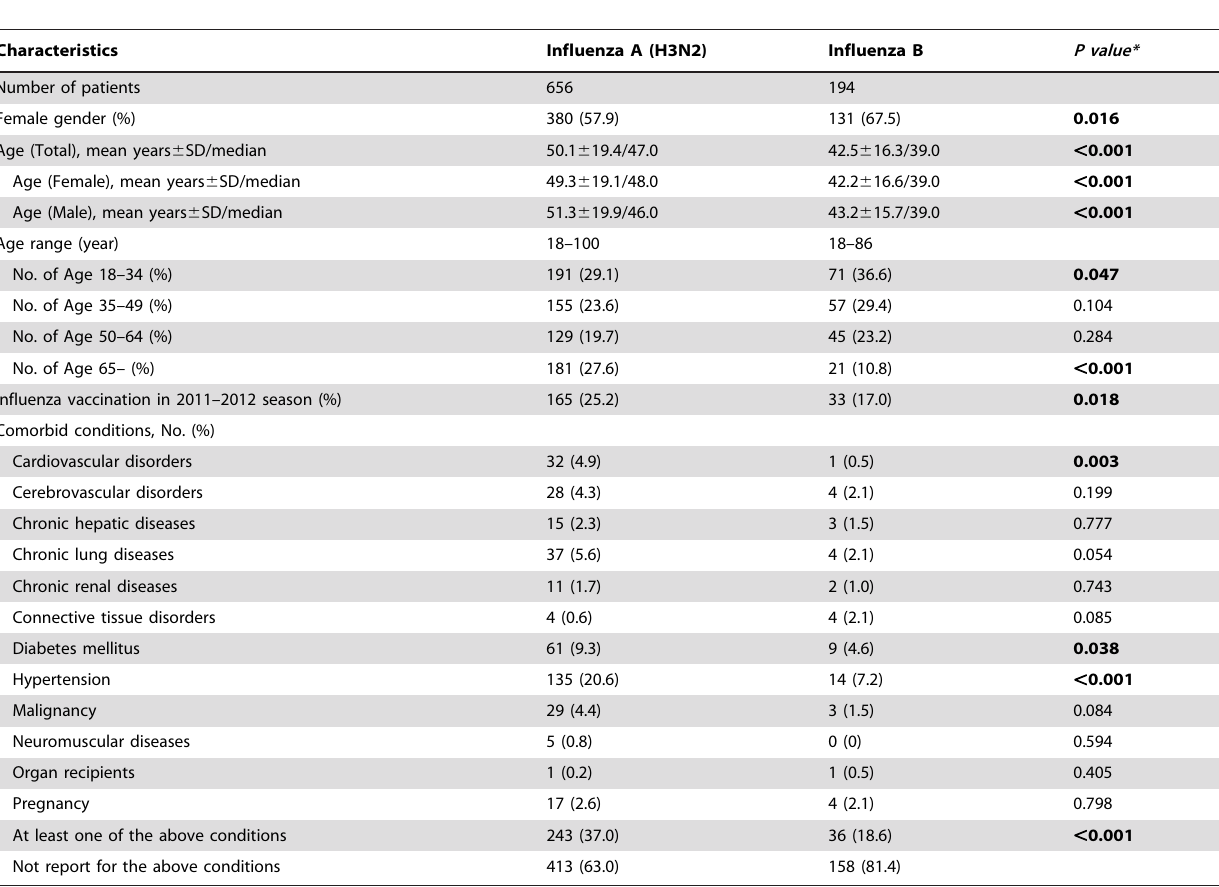
Table 1. Demographic and epidemiologic characteristics of patients with laboratory-confirmed Influenza A (H3N2) and Influenza B from October 2011 to May 2012.